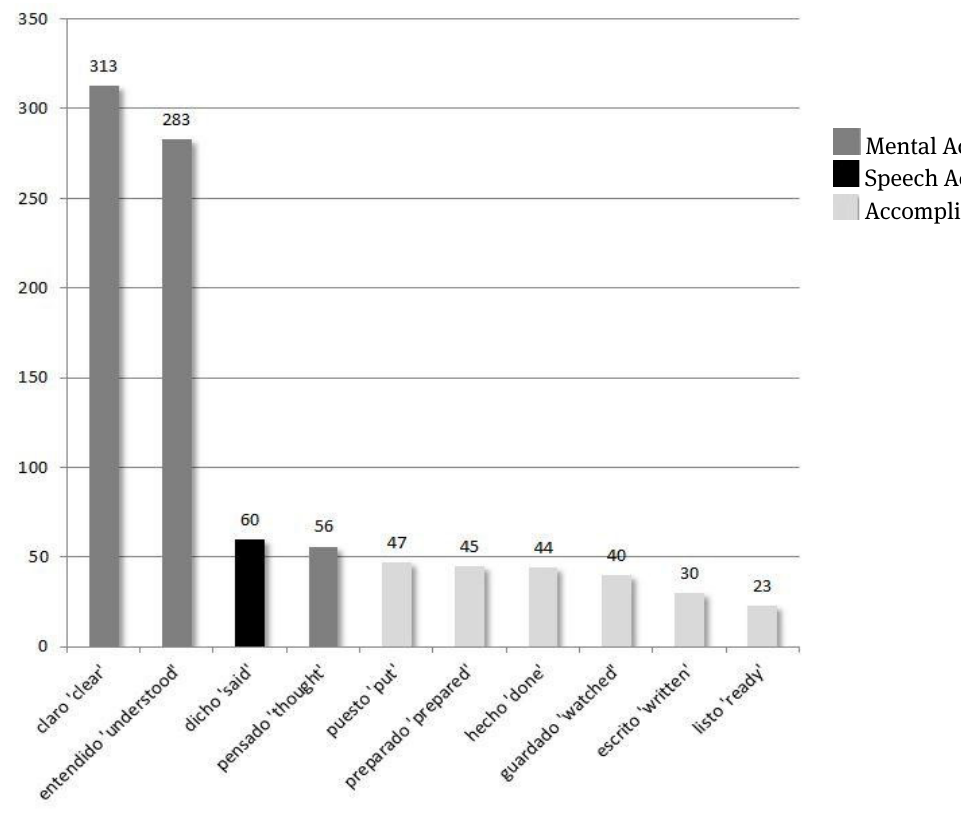
Figure 3. The ten most frequent instances of first-person uses of tener + past